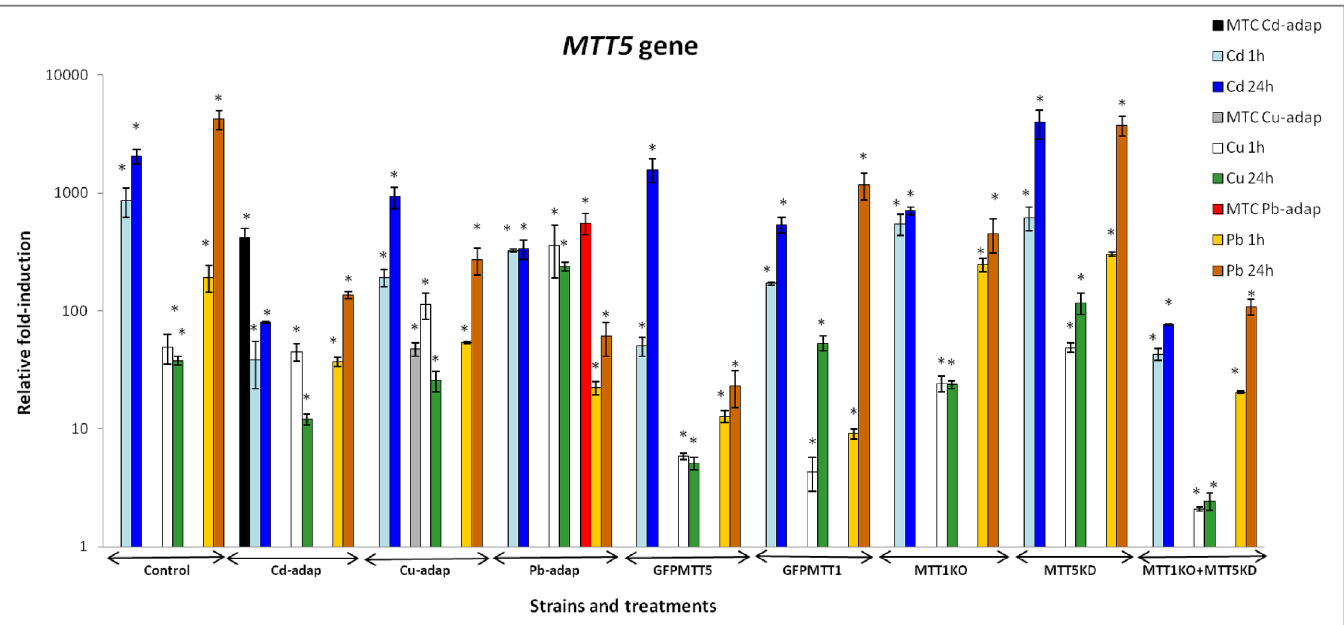
Fig 4. Comparison of relative fold-induction of MTT5 in different T . thermophila strains. MTC: maximum tolerated concentration (115 μ M Cd 2+ , 4 mM Cu 2+ or 5.5 mM Pb 2+ ). β -actinwas used as the normalizergene. Each histogrambar represents an averagevalue ± standarddeviation(see S3 Table) from two or three independentexperiments. Relativeinductionvalues are representedin a logarithmic scale. Asterisks indicatesignificantdifferencesfrom the control with p (cid:20)